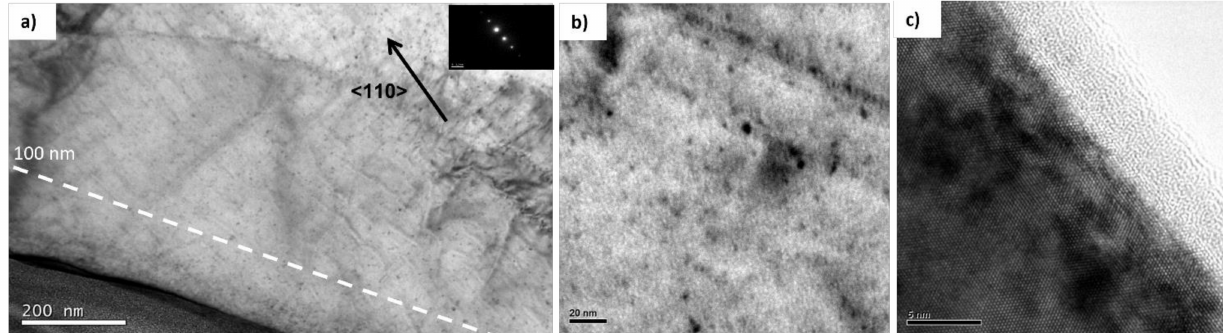
Figure 10. Representative microstructures of the irradiated bulk samples under the same conditions as the thin films, at different magnifications, showing the first 500 nm in depth ( a ), focusing on the first 100 nm ( b ) and very close to the surface ( c ).